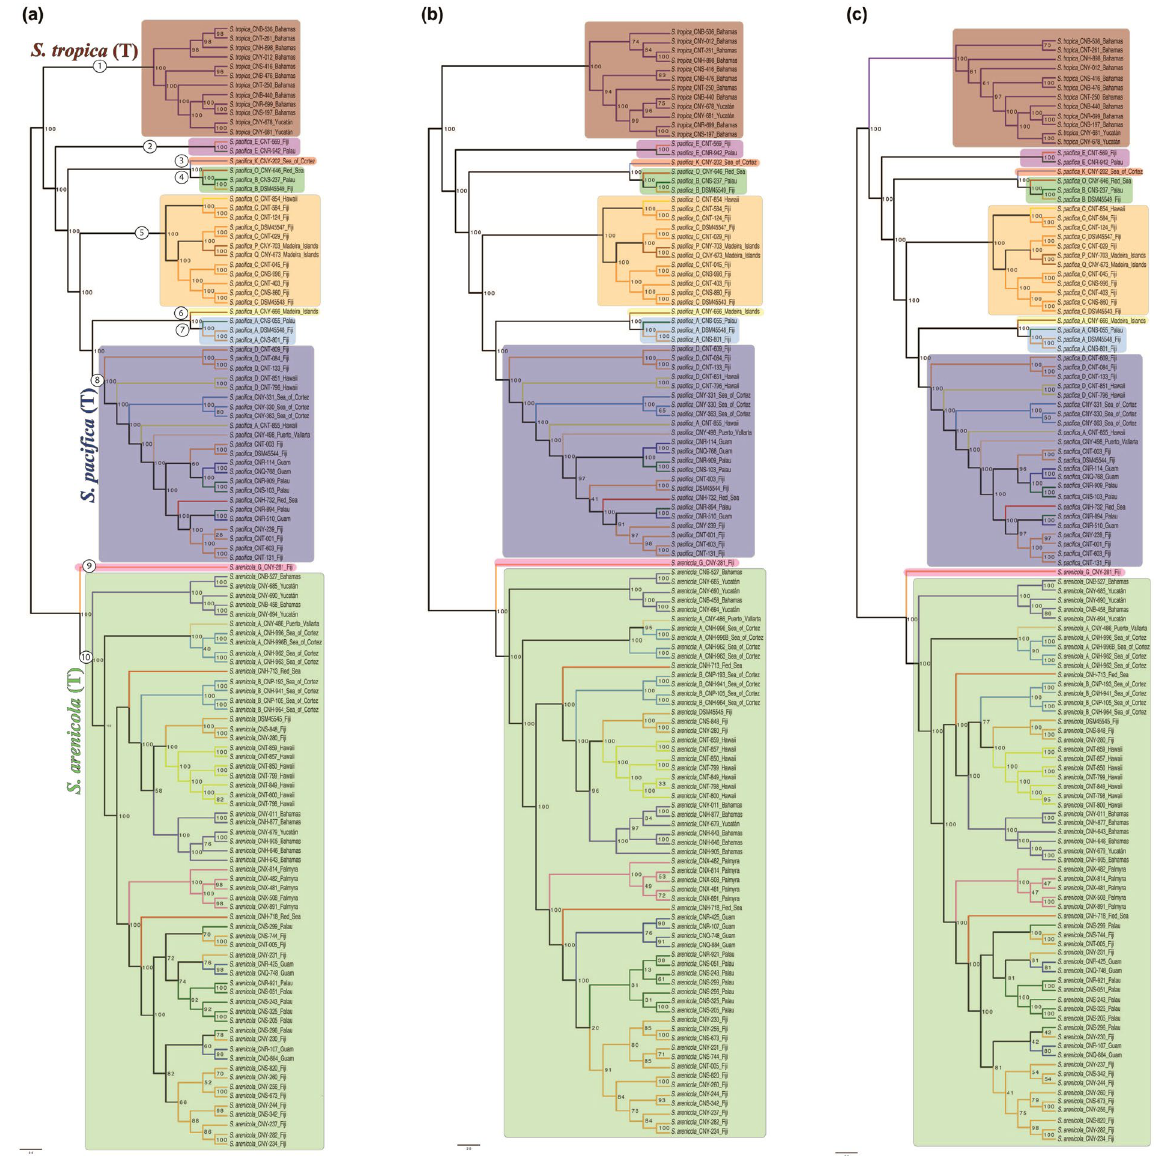
Figure 5. Effects of recombination on phylogenetic resolution using ANI species designations. ( a) Phylogenomic tree based on a concatenation of 2362 shared, single-copy genes. Each sequence or clade that shares < 95% ANI with neighboring strains is numbered 1–10 (corresponding to Fig. 4) and shaded with a different color. Species names are listed corresponding to the clades associated with the type strains (T). ( b) Phylogeny based on genes with no evidence of recombination. ( c) Phylogeny based on genes with evidence of